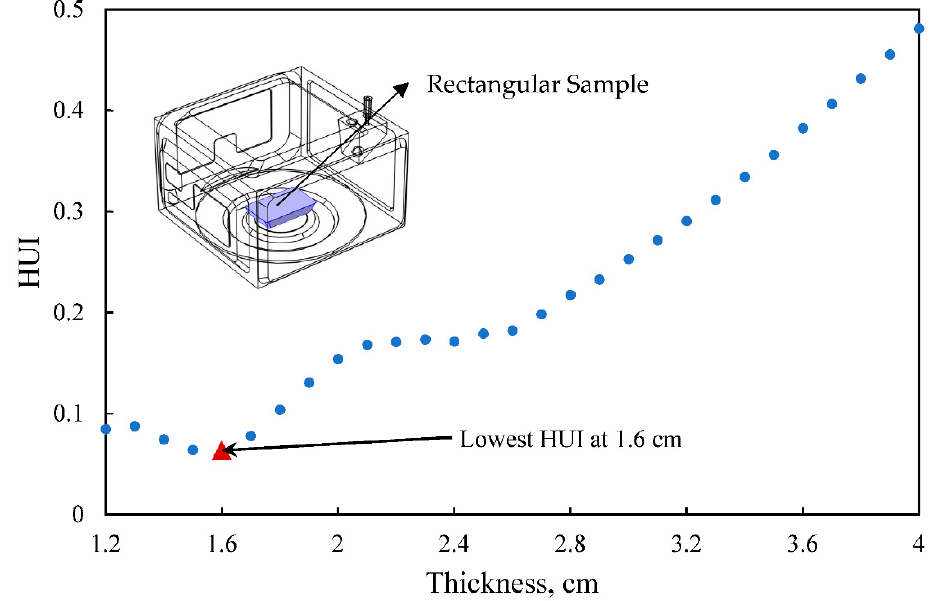
Figure 7. The heating uniformity index (HUI) of temperature at different thicknesses determined by using the parametric sweep approach of mechanistic-modeling for thickness sweeping from 1.2 to 4.0 cm with a step size of 0.1 cm.